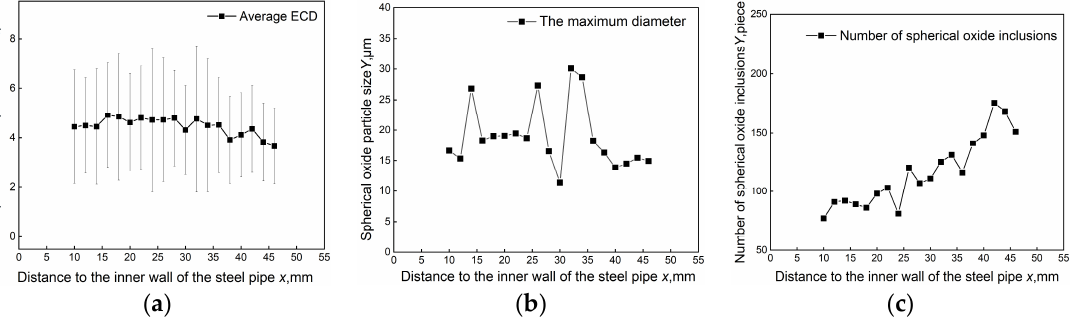
Figure 3. Original statistical distribution of non-metallic spherical oxide inclusions based on ECD in ( a ) sample 1# and ( b ) sample 2#.